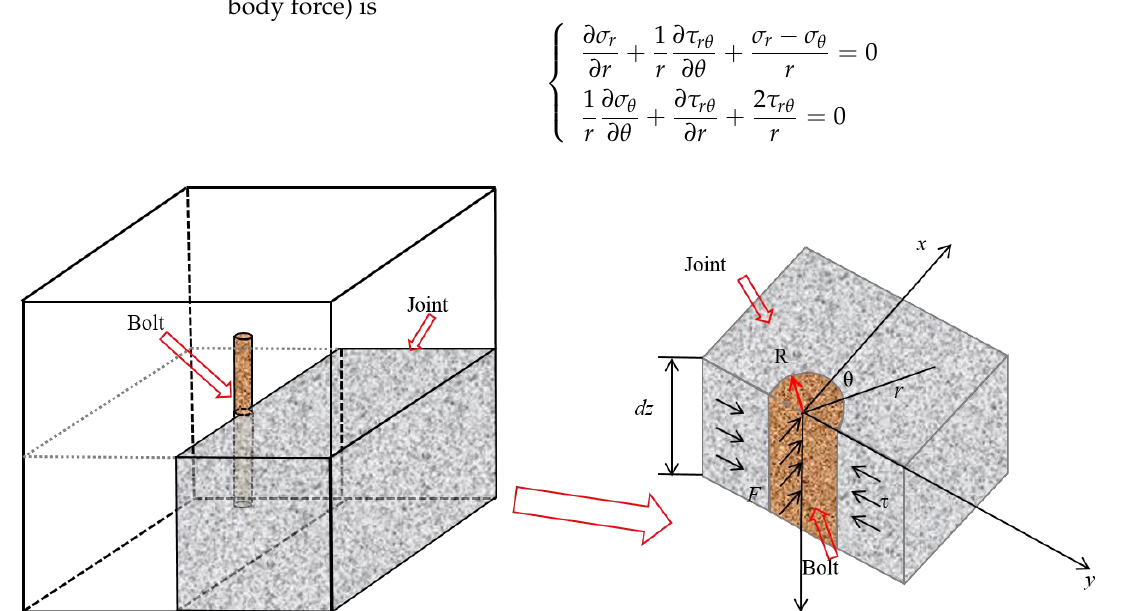
Figure 2. Calculation model of bolted rock joints.